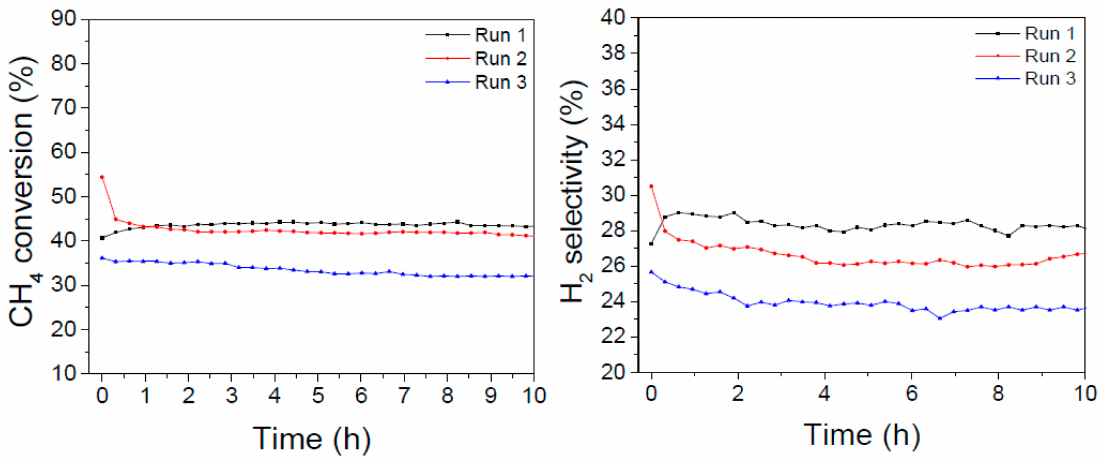
Figure 8. CH 4 conversion and H 2 selectivity as function of time of La 0.8 Ba 0.2 NiO 3 under successive catalytic runs.